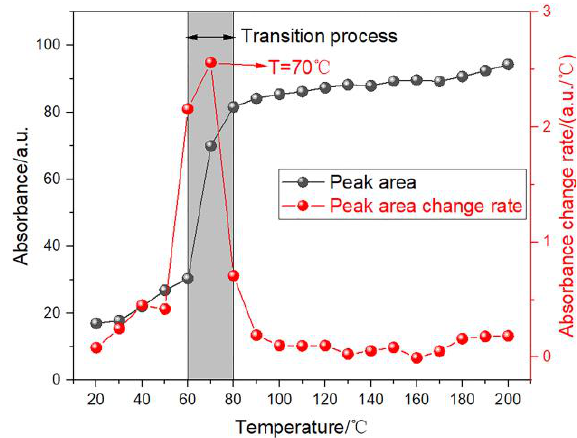
Figure 8. Group change during heating